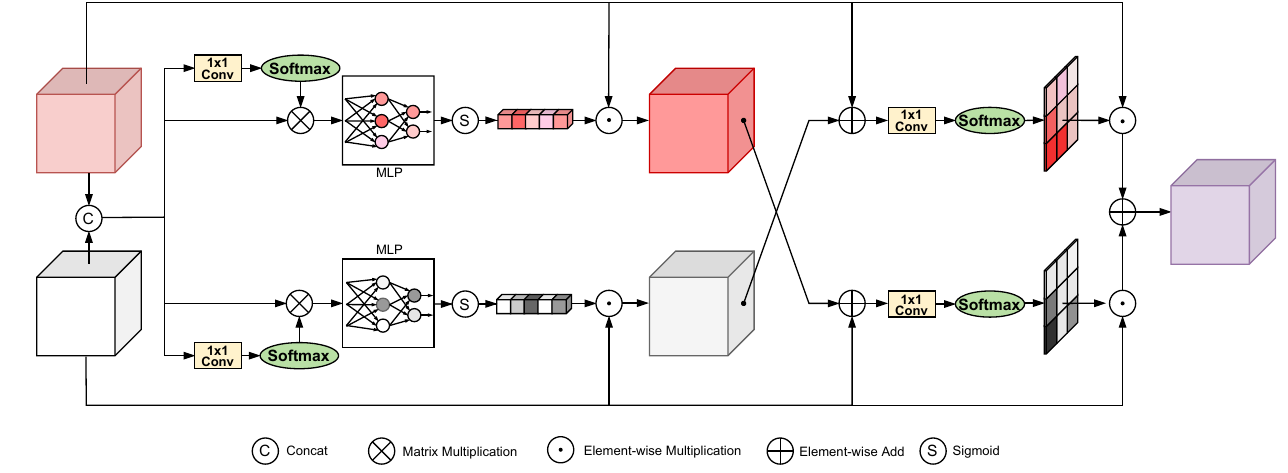
Figure 3. The architecture of cross-modal feature recalibration